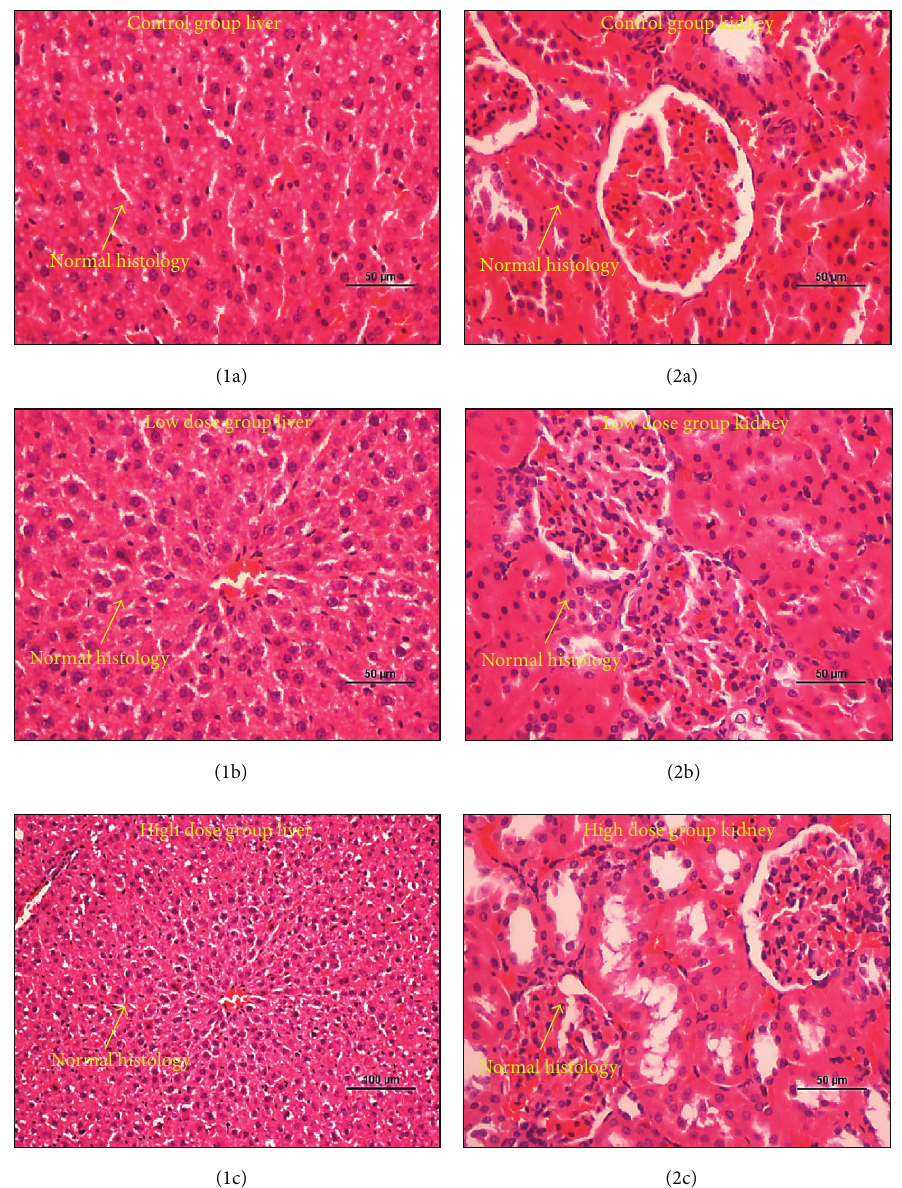
Figure 1: Microscopic images of representative tissue sections showing the histopathology evaluation of the organs of toxicity among SD rat groups. (1a) and (2a) are vehicle (control) groups with normal histology of liver and kidneys, respectively. (1b) and (2b) are low dose (2 gm/Kg) groups with normal histology of liver and kidneys, respectively. (1c) and (2c) are high dose (4 gm/Kg) groups with normal histology of liver and kidneys, respectively. Sections were stained with H&E